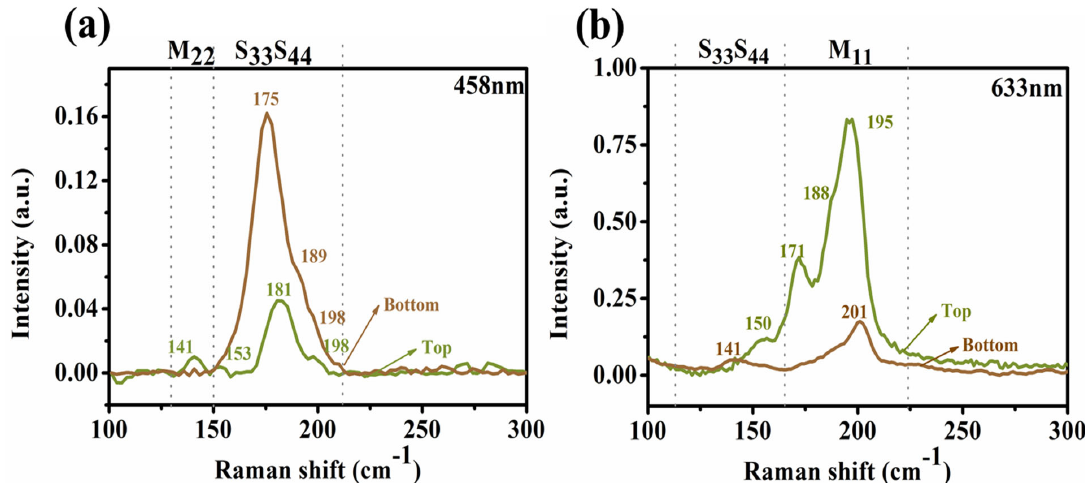
Figure 8. Raman spectra of the top green and bottom brown fractions in the ranges of 100–300 cm − 1 at the excitations of ( a ) 458 and ( b ) 633 nm, respectively.